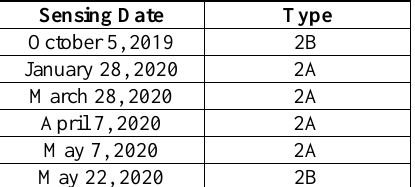
Table 1 . Downloaded Sentinel-2 satellite